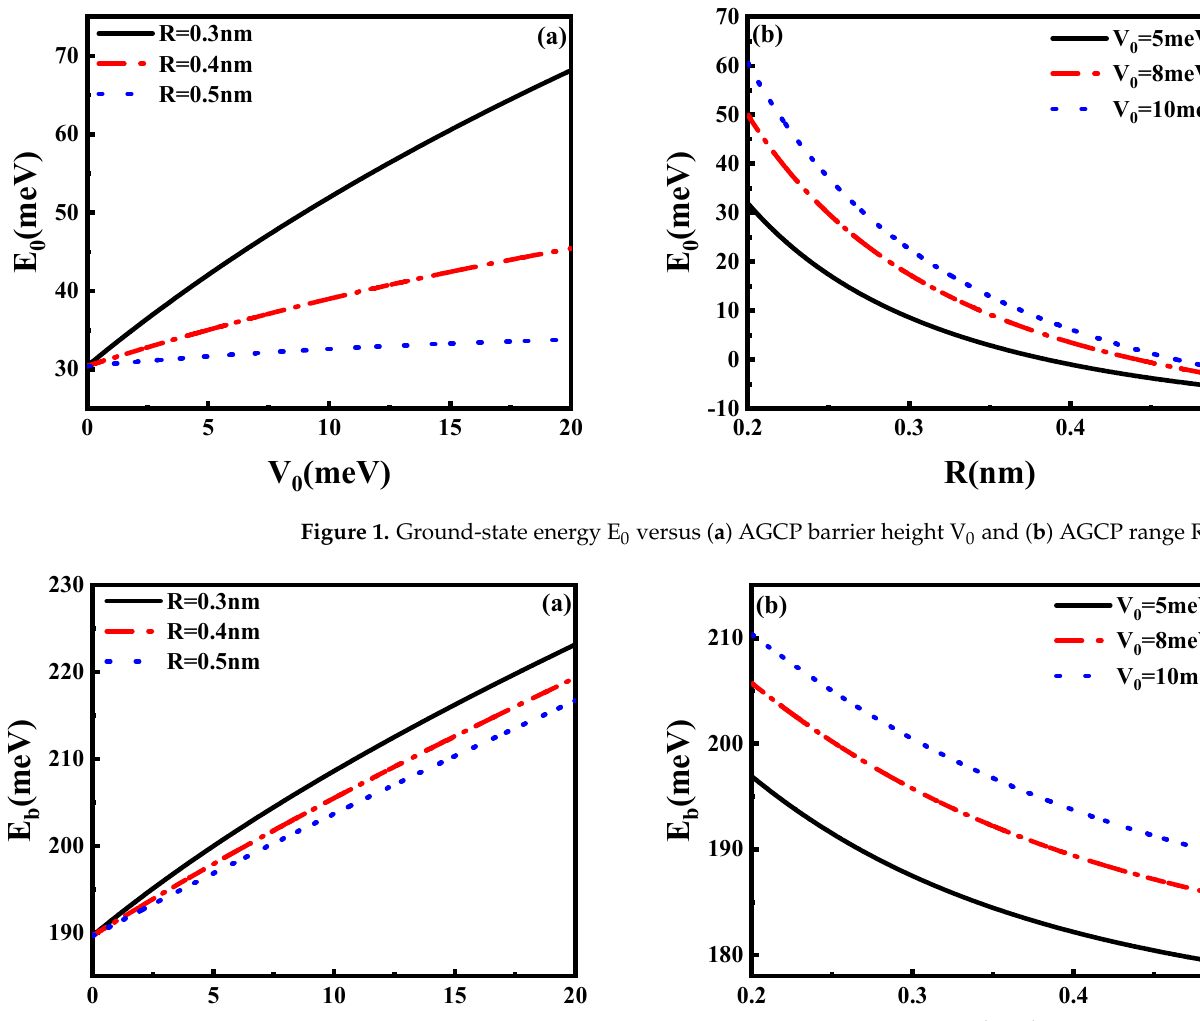
Figure 2. Ground-state binding energy E b versus ( a ) AGCP barrier height V 0 and ( b ) AGCP range